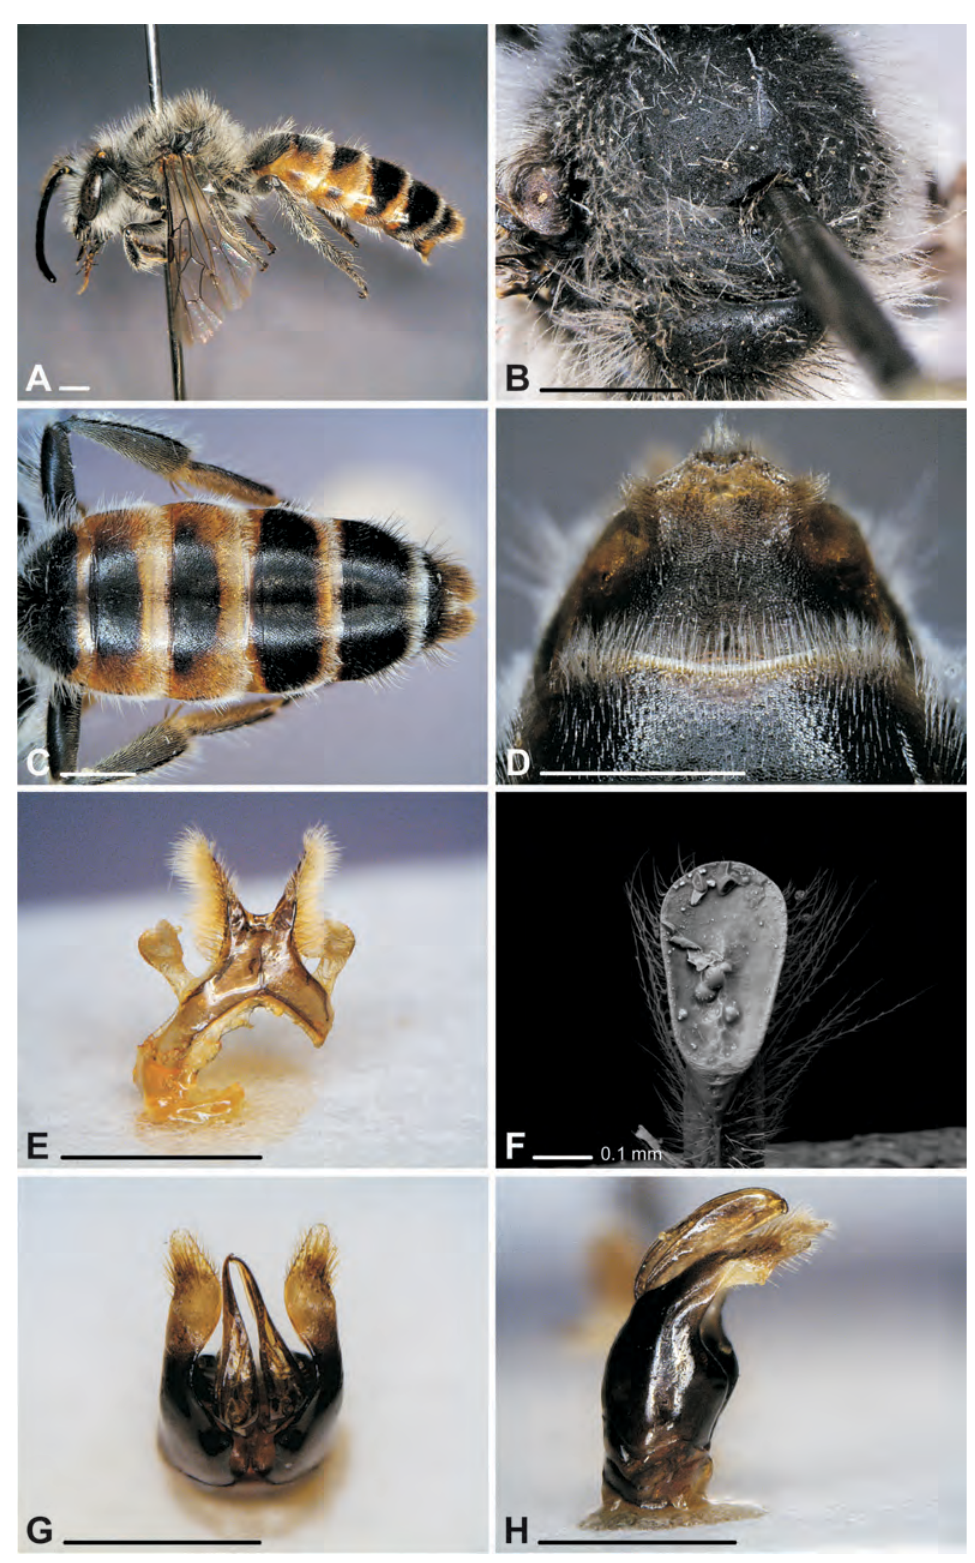
Fig. 3. Redivivoides capensis sp. nov., ♂. A . lateral view. B . Scutum and scutellum. C . Metasoma (dorsal view). D . S6 (ventral view). E . S7 (dorsal view). F . S8, apical end (backscattered electron image). G . Genitalia (dorsal view). H . Genitalia (lateral view). Scale bar: 1